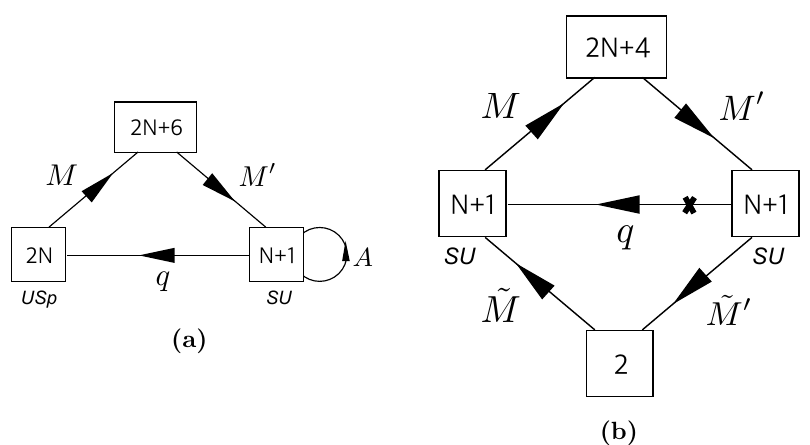
Figure 2. Basic (cid:13)ux domain walls. Figure (a) is the USp(2 N ) SU( N +1) type domain wall with (cid:0) (cid:13)ux 1/4 preserving U(1) SU(2 N +6) symmetry. USp(2 N ) SU( N +1) symmetry are gauged by (cid:2) (cid:2) the 5 d bulk gauge groups. The chiral (cid:12)elds M and M 0 are from the hypermultiplets with Neumann boundary conditions on the two sides of the wall. Figure (b) is the SU( N +1) SU( N +1) type (cid:0) domain wall with (cid:13)ux 1/2 preserving U(1) SU(2) SU(4 N + 8) symmetry. SU( N +1) SU( N (cid:2) (cid:2) (cid:2)